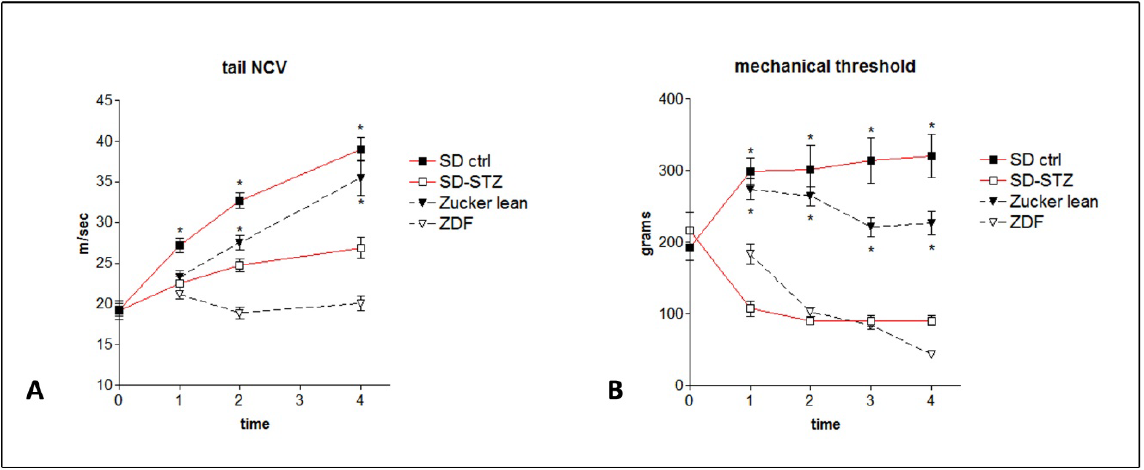
Figure 3. Changes in NCV ( A ) and mechanical threshold ( B ) over the period of observation; SD-STZ and ZDF diabetic rats are compared with their non-diabetic controls at the different time points as follows: 0 = at the moment of STZ injection; 1 = 8 weeks after STZ injection (SD-STZ rats) or 8 weeks of age (ZDF rats); 2 = 16 weeks after STZ injection (SD-STZ rats) or 16 weeks of age (ZDF rats); 3 = 24 weeks after STZ injection (SD-STZ rats) or 24 weeks of age (ZDF rats); 4 = 32 weeks after STZ injection (SD- STZ rats) or 32 weeks of age (ZDF rats). Values represent mean +/− SEM (*) = p < 0.001.